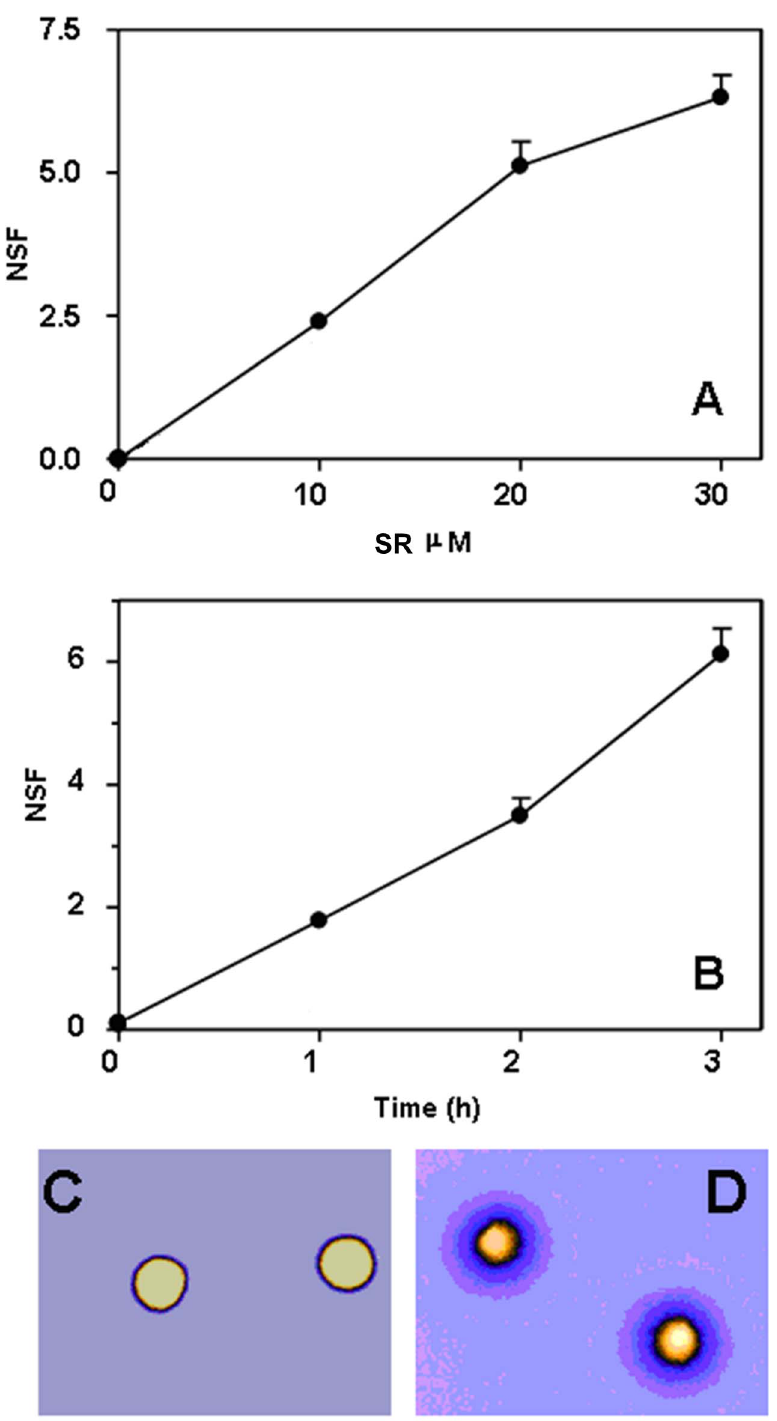
Figure 5. SR induces DNA damage in REH cells. Cells were treated with increasing concentrations of, or for increasing time intervals with, SR and immediately assayed for DNA breakage with FHA. A) DNA single strand breakage induced by 3 h SR treatment in REH cells. B) DNA single strand breakage induced by 30 m M SR in REH cells as a function of incubation time. Data are presented as mean 6 SEM of three different experiments. C) and D) Representative, digitally pseudocolored (ICA look up table of the Image J software) micrographs of FHA-processed control (C) or 30 m M SR- treated (D) REH cells are also shown: note the wide halos in D as compared to C. Also shown (panel A, inset) the extent of DNA double strand breakage caused by SR (30 m M for 3 h) or etoposide (1 m g/mL for 3 h) in REH cells. Data are expressed as NSF (nuclear diffusion factor), which represents the ratio between the total area of the halo and nucleus and that of the nucleus.